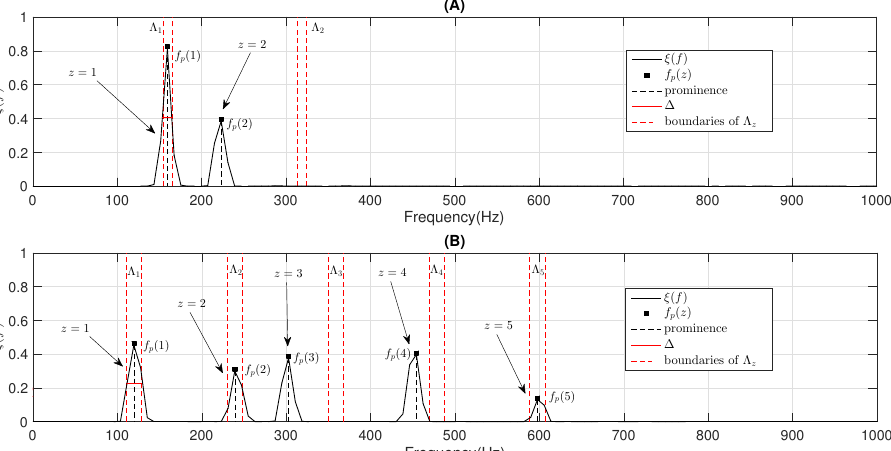
Figure 8. Example of the proposed two-step procedure to classify between MP and PP wheezing when η > 1, considering the two examples of PP wheezing shown in Figure 2. ( A ) Two-step procedure applied to the PP wheezing shown in Figure 2A. ( B ) Two-step procedure applied to the PP wheezing shown in Figure 2B. Note that the arrows indicate the narrowband spectral peaks that compose the wheezing. In this case, both wheezing are classified as PP because not all spectral peaks are harmonically